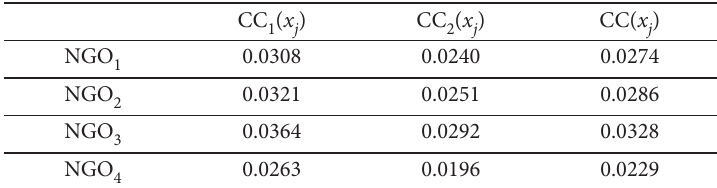
Table 10. The closeness